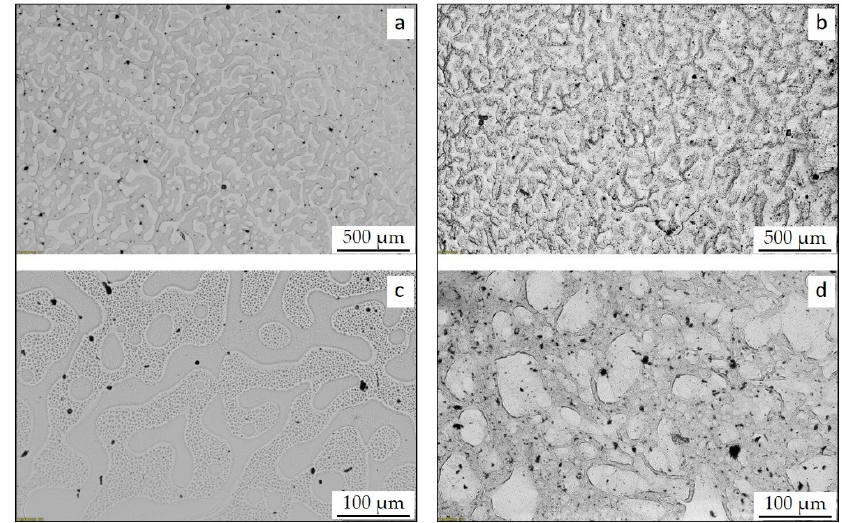
Figure 5. TLM images of PS / PB blends with 1 wt % of CNT-PS dispersed in toluene ( a , c ) and chloroform ( b , d ) prepared on glass substrates; ( c , d ) at higher magnification.